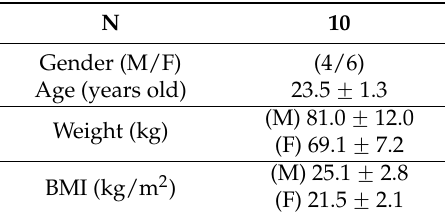
Table 4. Summary of the demographic and anthropomorphic characteristics of the volunteers taking part in the study. Data are shown as the mean value ˘